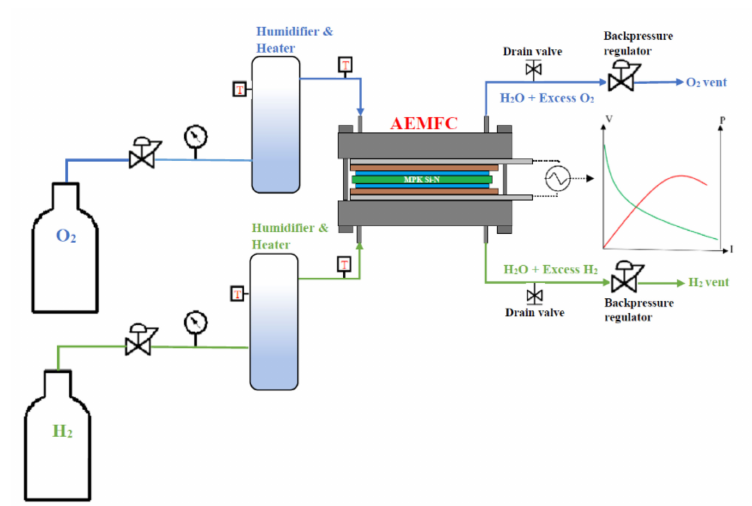
Scheme 1. Schematic layout of the fuel cell